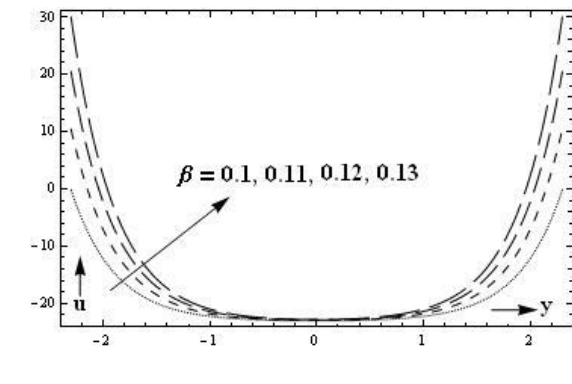
Figure 15 . Velocity profile for various values of slip parameters.